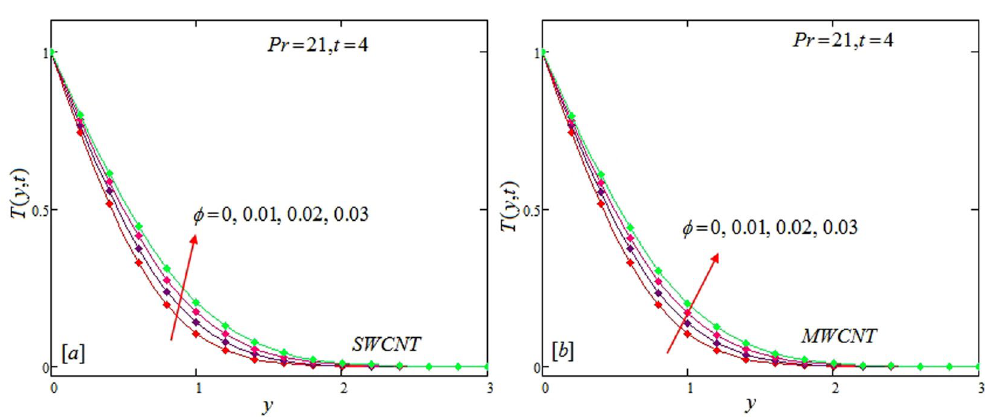
Figure 4. Temperature profiles for single and multiple wall CNTs for different values of volume fraction.